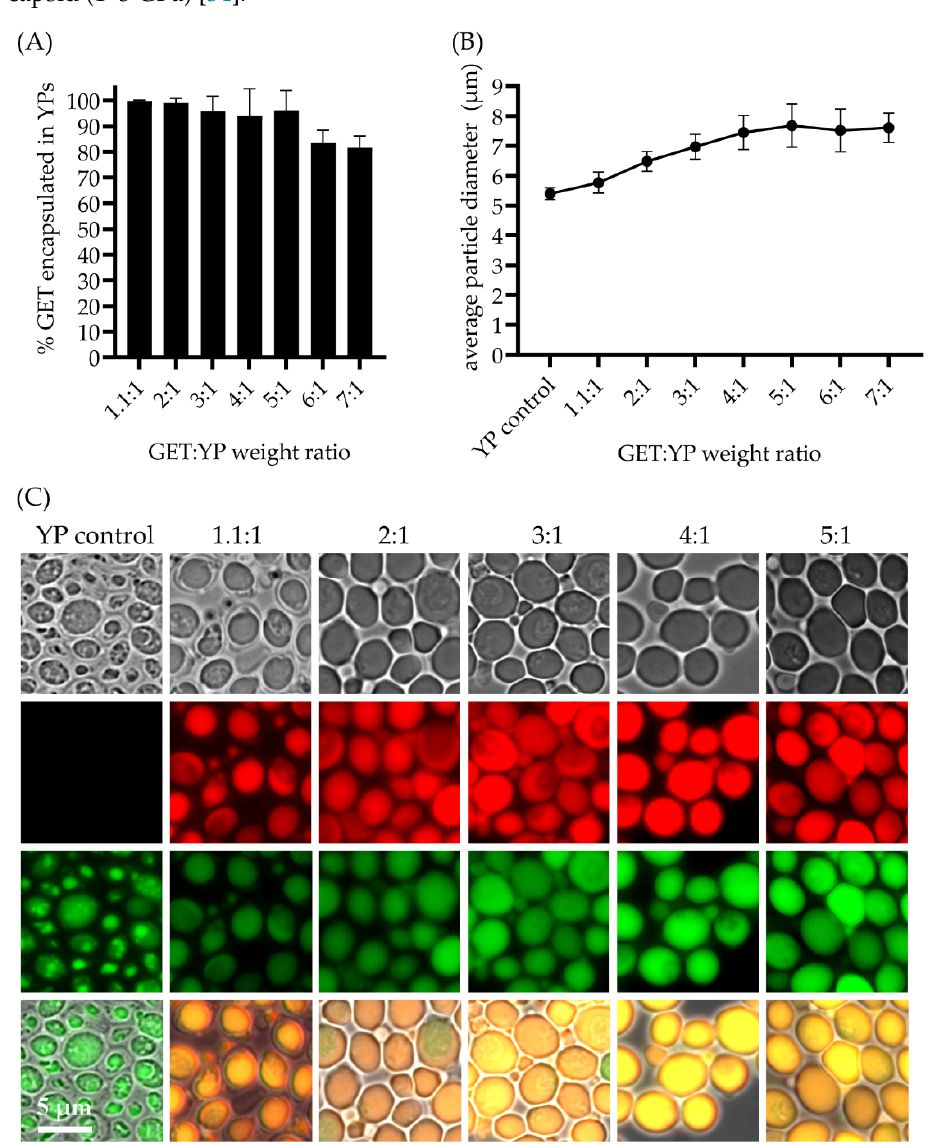
Figure 3. ( A ) Terpene encapsulation efficiency in YPs at GET:YP weight ratios from 1.1:1 up to 7:1 of samples prepared at 150 g YP/L (1.1:1 to 5:1 GET:YP) and 100 g YP/L (6:1 and 7:1 GET:YP), ( B ) average particle size of empty YP control and GET loaded YPs, and ( C ) microscopy pictures of control and GET loaded particles showing YP stained with FITC ConA and encapsulated terpenes